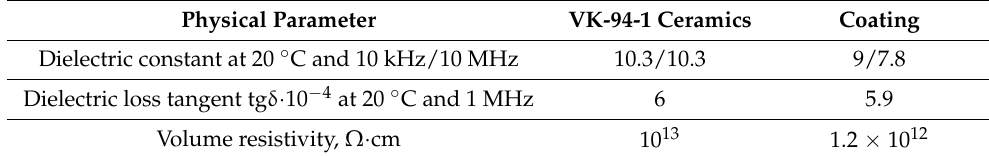
Table 4. Dielectric parameters of the original target and the deposited